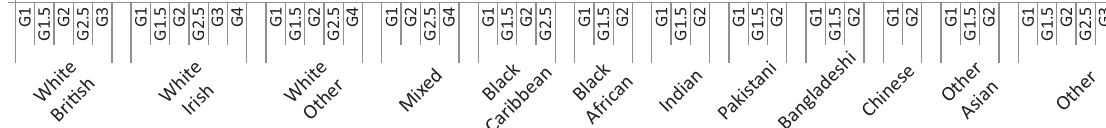
Figure 3. Average marginal effects of ethnicity on degree attainment, model controlling for class, age, and sex. Source: Understanding